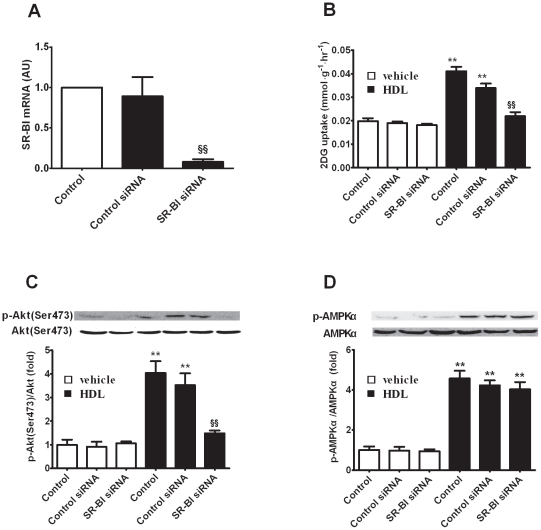
HDL prompts glucose uptake via SR-BI.(A) The relative expression of SR-BI to GAPDH in 3T3-L1 adipocytes with treatment of vehicle, control siRNA and SR-BI siRNA. (B) Glucose uptake in 3T3-L1 adipocytes with and without SR-BI RNA interfering were incubated in the absence or presence of HDL (50 µg protein/ml), n = 6. (C and D) Akt (C) and AMPKα (D) phosphorylation in 3T3-L1 adipocytes with and without SR-BI RNA interfering were incubated in the absence or presence of HDL (50 µg protein/ml), n = 3. Data are expressed as mean±SEM of three independent experiments. ** p<0.01, vs vehicle; §§ p<0.01, vs control RNA interfering.